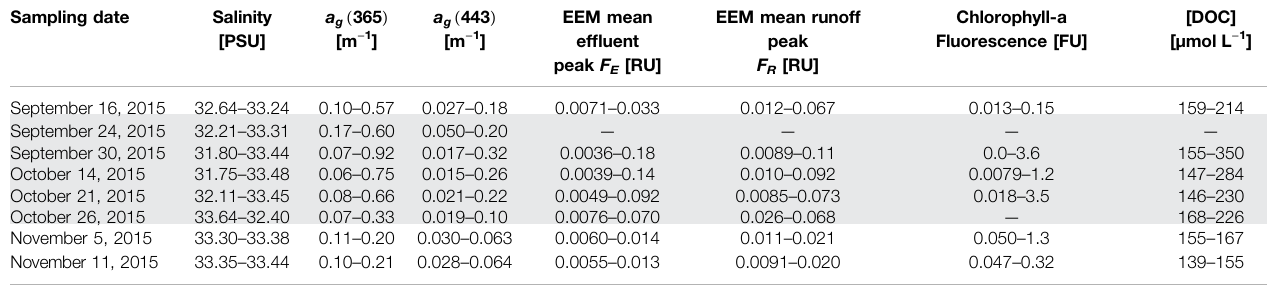
TABLE 1 | Summary of in-situ variables. Ranges of observed environmental parameters are reported for each sampling day. Gray rows denote sampling conducted during the wastewater ef fl uent